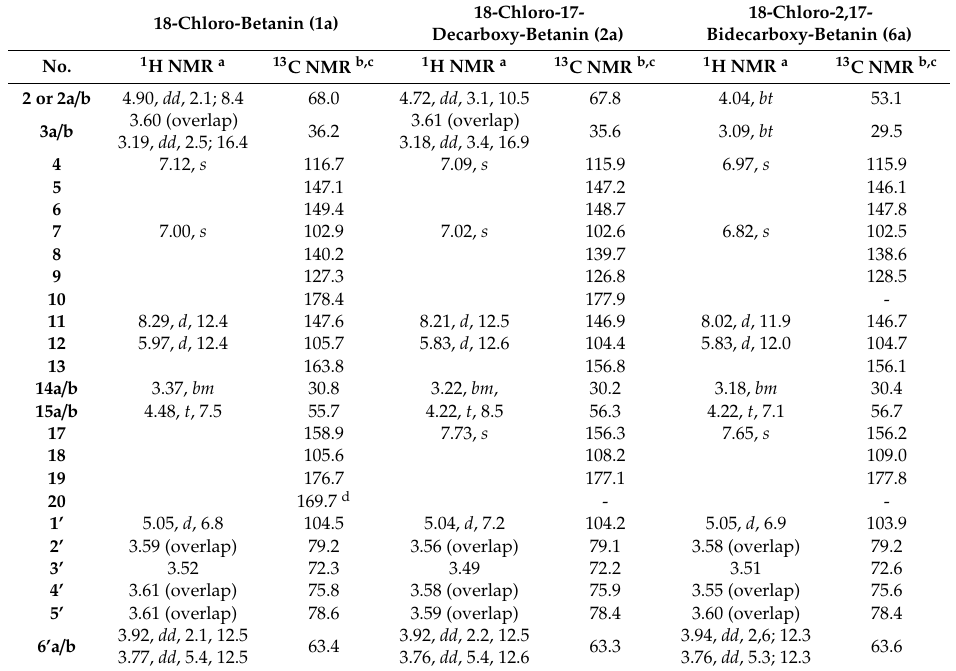
Table 3. The NMR data of analyzed 18-chloro-betanin 1a , 18-chloro-17-decarboxy-betanin 2a and 18-chloro-2,17-bidecarboxy-betanin 6a . Important HMBC and NOESY correlations for 1a are depicted in Figure